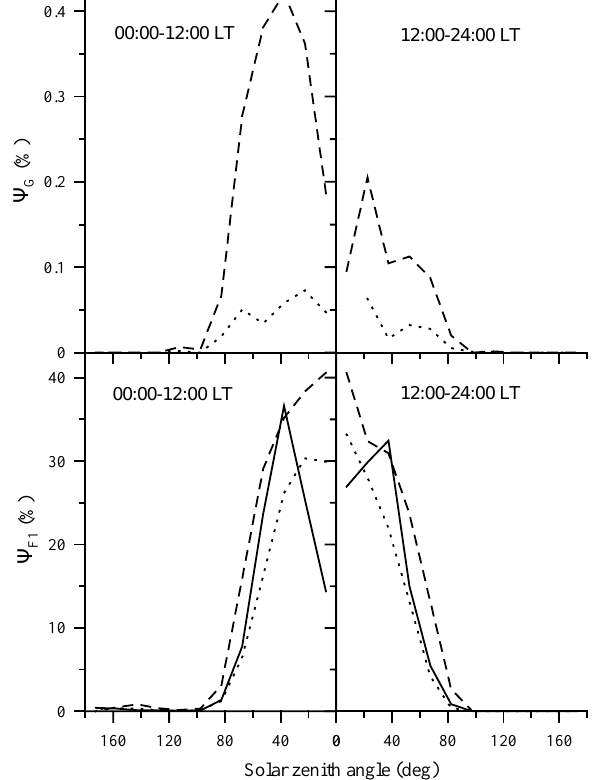
Fig. 2. The dependence of the F1-layer (two bottom panels), and G condition (two top panels) probability functions on the solar zenith angle in latitude range 2 (10 ◦ < | 8 | ≤ 30 ◦ ) during the winter (solid lines), summer (dashed lines), and spring and autumn (dotted lines) months before midday from 00:00LT to 12:00LT (left panels), and after midday from 12:00LT to 24:00LT (right